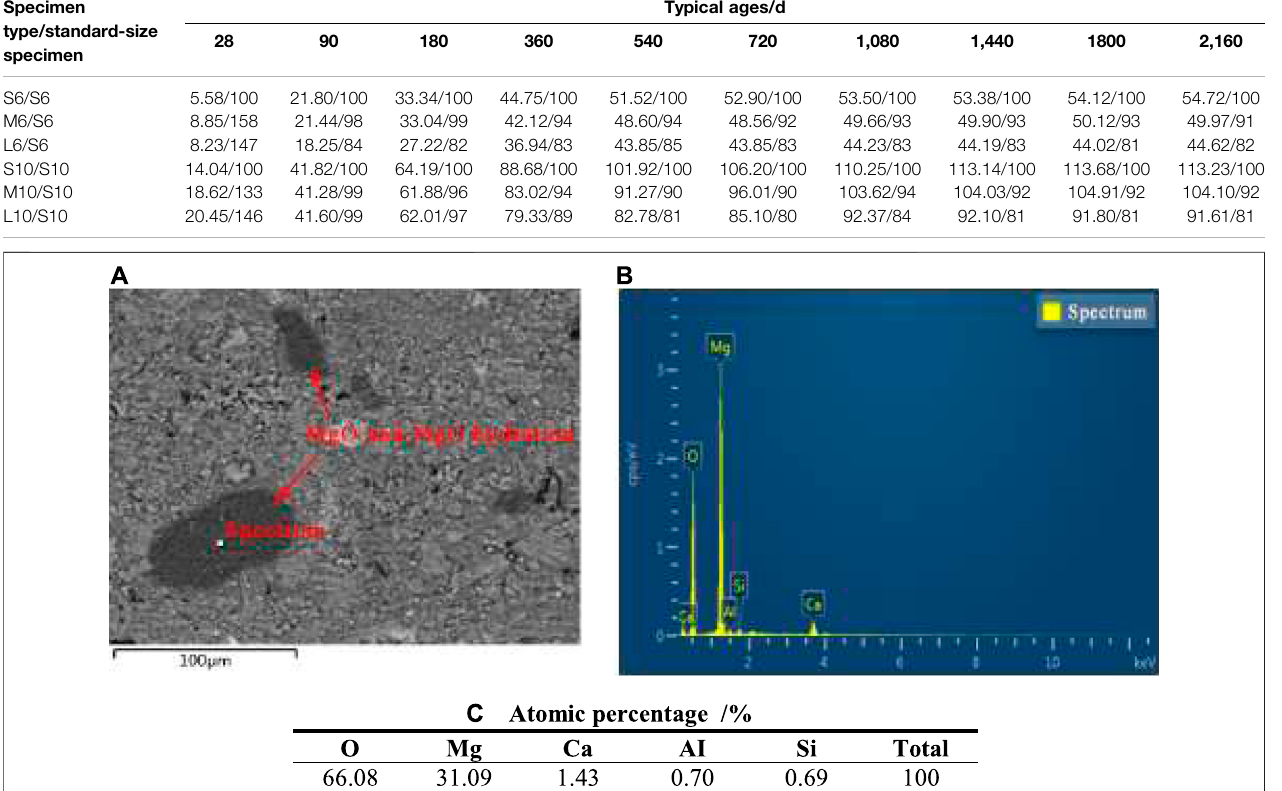
TABLE 3 | Theautogenous volume deformationvalues ofvarious specimensat typical ages and thedeformation values ofmedium- and large-size specimens relative tothe standard-size specimens/( × 10 − 6 /%). Specimen type/standard-size specimen